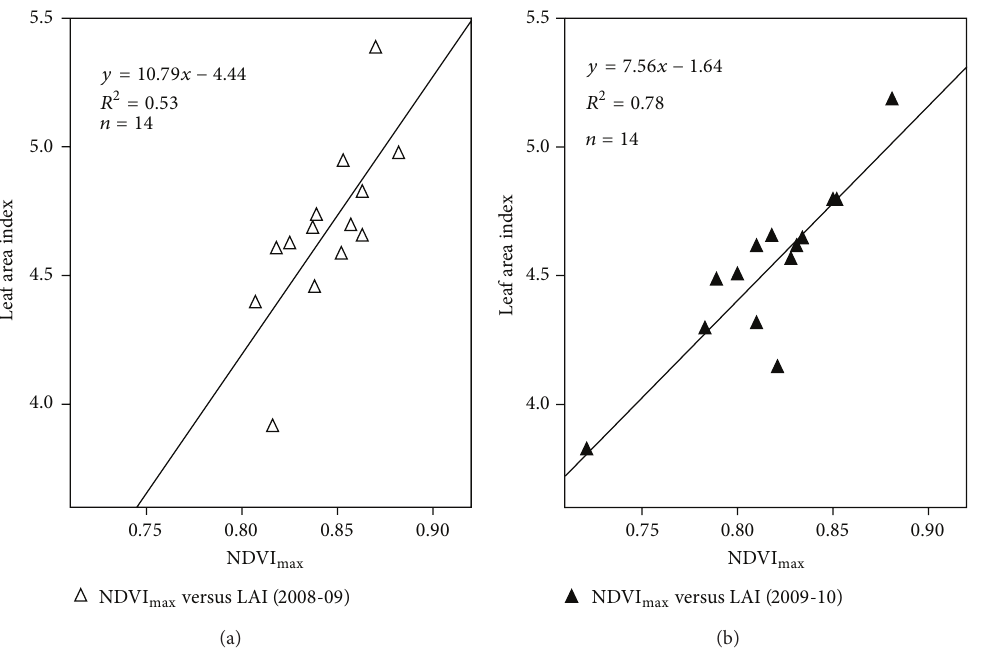
Figure 3: Relationship between leaf area index and NDVI max